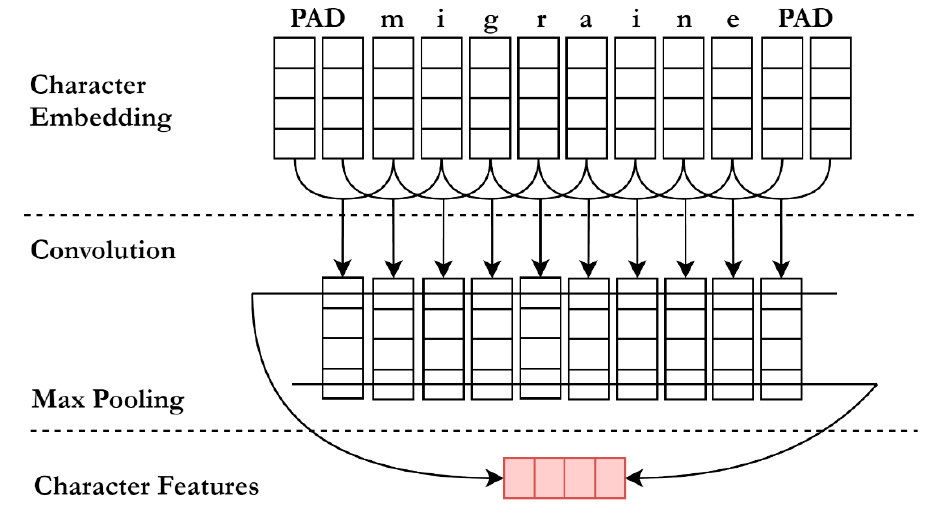
Figure A1. CNN for extracting character-level Figure B1. CNN for extracting character-level features.